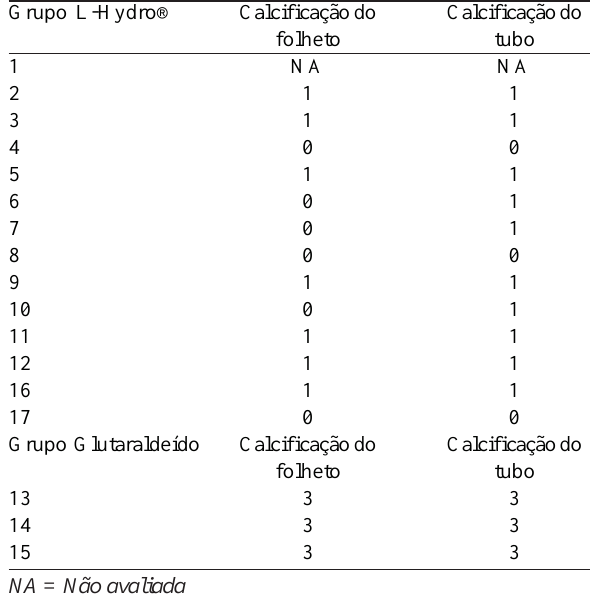
Tabela 5. Mensuração de calcificação: 0- ausência de calcificação;